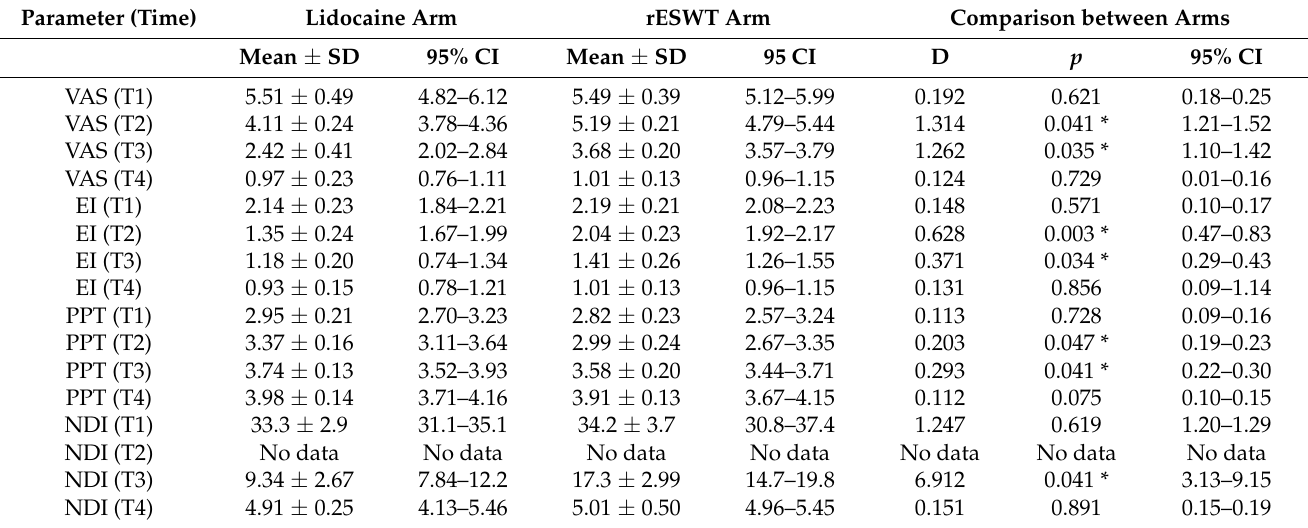
Table 2. Outcome measures at T1, T2, T3, and T4, and comparison between arms (post hoc analysis).